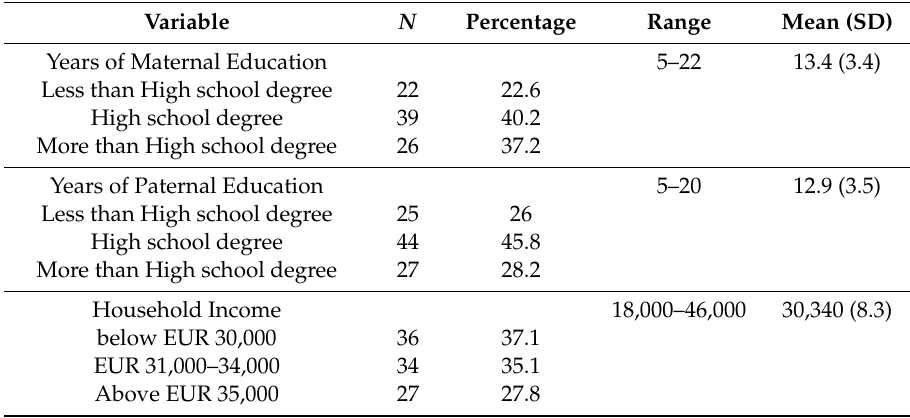
Table 1. Descriptive statistics of SES